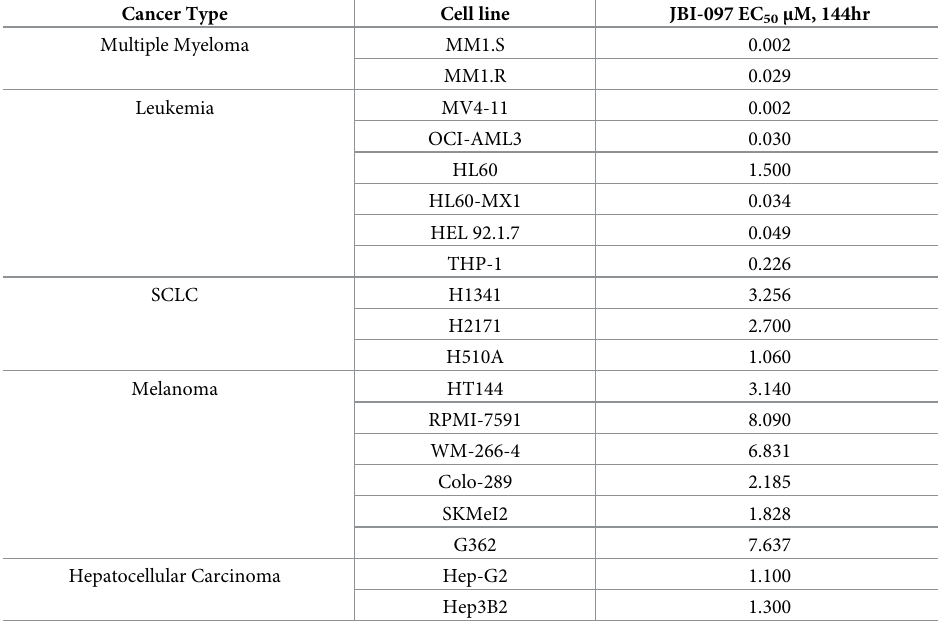
Table 2. Anti-proliferative activity of JBI-097 in various cancer cell